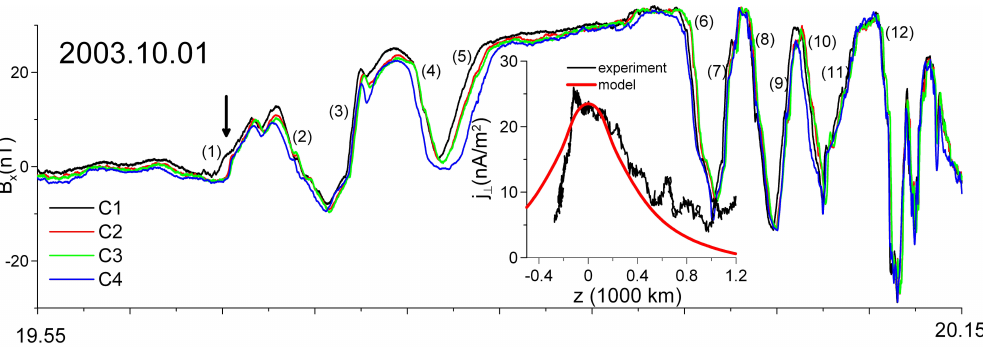
Fig. 4. Component of magnetic field B x observed by four spacecraft and comparison of the current density profile with that of our TCS model (in the insert). Individual crossings are marked by numbers.